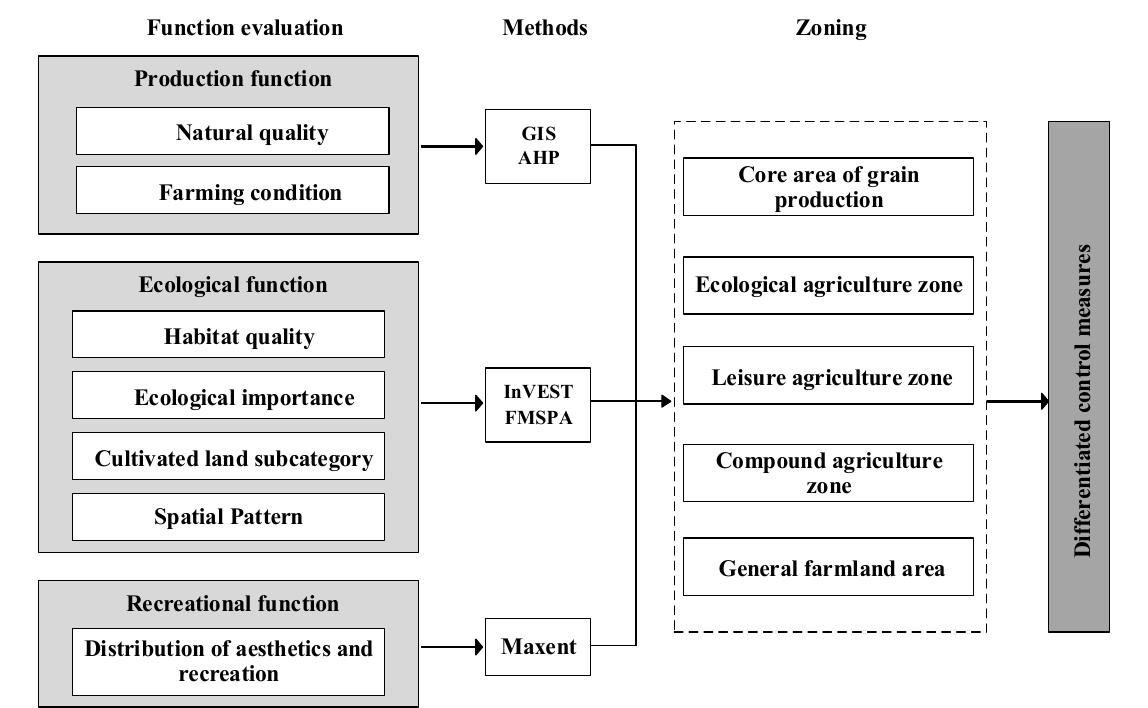
Figure 2. Flowchart of the datasets and approaches employed in the evaluation and zoning of the cultivated land in this study.